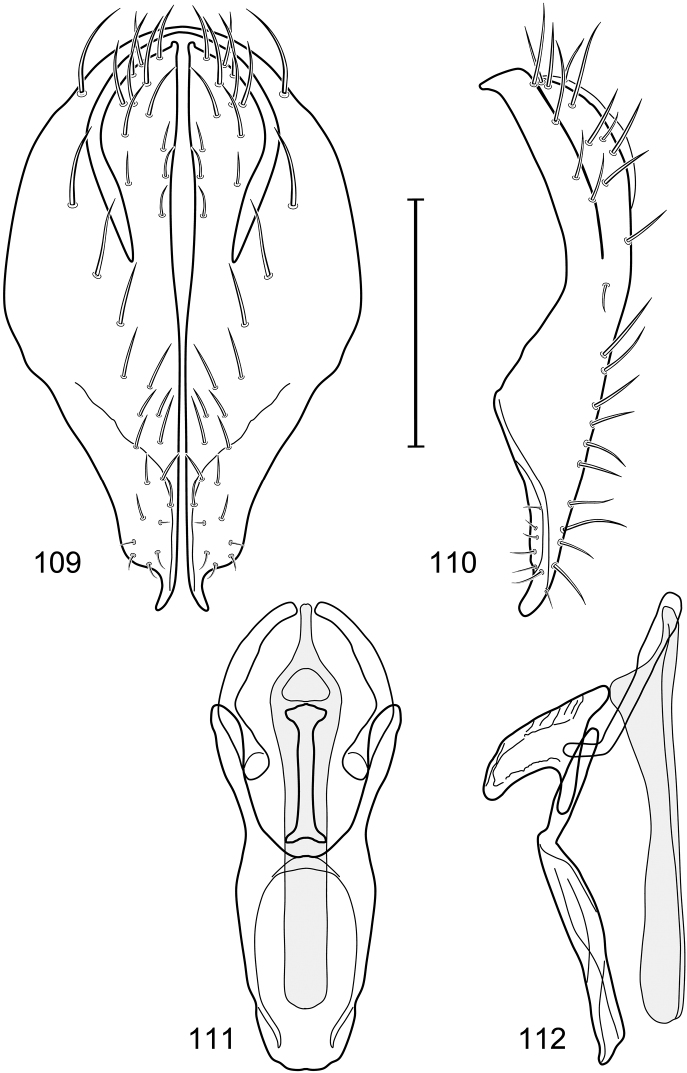
Illustration of Polytrichophora sturtevantorum sp. n. (male) (Illinois. Cass: Beardstown) 109 epandrium and cerci, posterior view 110 same, lateral view 111 internal structures of male terminalia (aedeagus [shaded], phallapodeme, gonite, hypandrium), ventral view 112 same, lateral view. Scale bar = 0.1 mm.